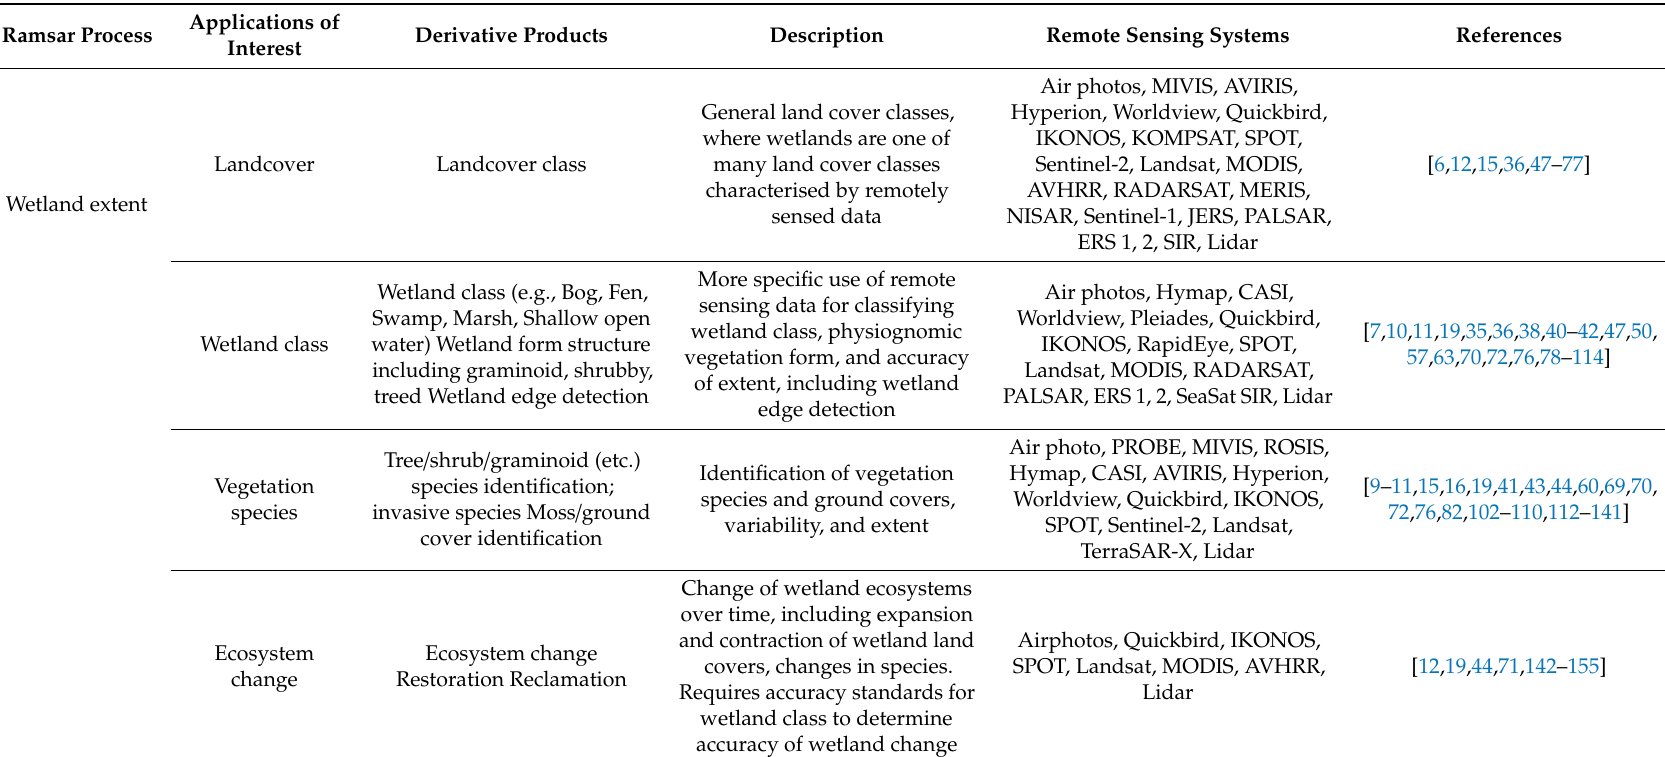
Table 1. Historical to current remote sensing derivative products, classes, and descriptions used to study boreal wetland ecosystems within the context of the Ramsar Convention. Ramsar Convention processes of interest for wetlands examined in the Table are divided into: Applications of Interest or wetland monitoring subjects of interest, derivative products, which can be derived from remote sensing data to support applications, descriptions of the derivative products produced by remotely sensed data, and References that have developed methods and derivative products using di ff erent remote sensing systems. References are used in comparisons in Figures